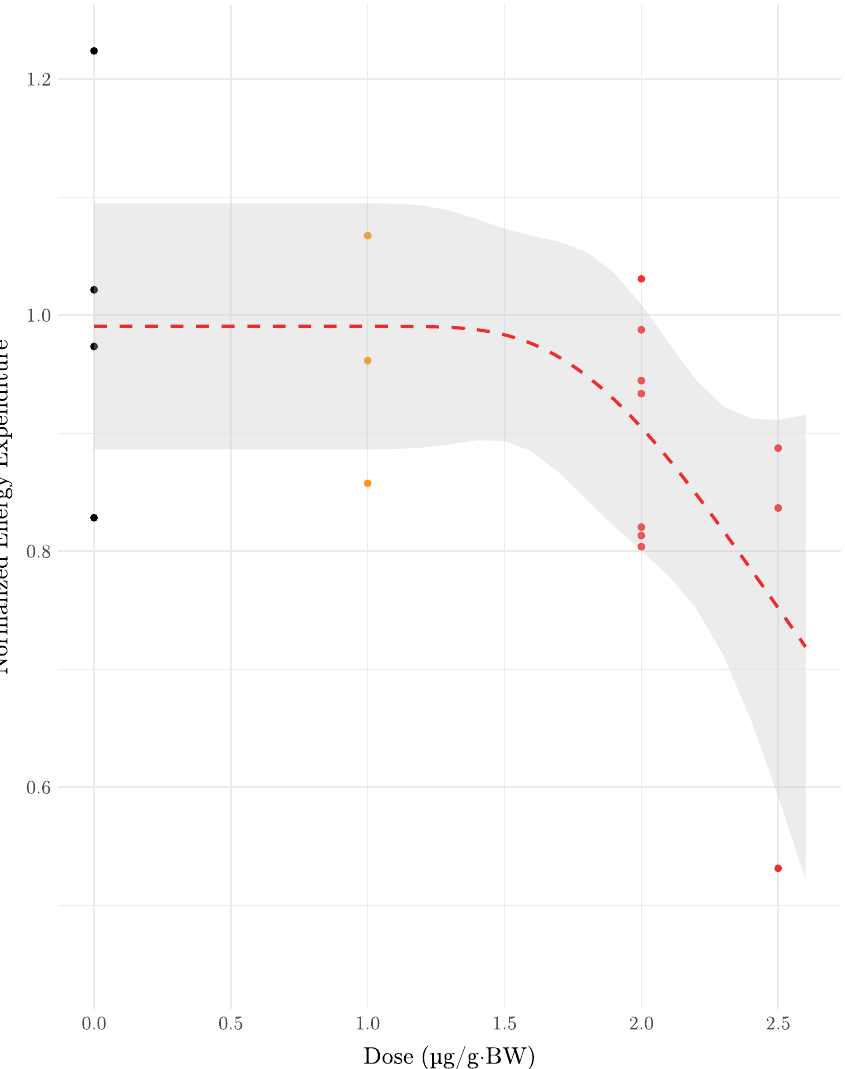
Figure 1. Energy expenditure of ruby-throated hummingbirds 1.5 h to 2 h after dosage with 0.0 µ g g − 1 to 2.5 µ g g − 1 · Body Weight (BW) imidacloprid follows a Weibull type 2 dose-response curve. Birds in the control group increased energy expenditure by an average of 1 % ± 7 % on days following dosage with the control solution, while birds in 1.0 µ g g − 1 · BW, 2.0 µ g g − 1 · BW, and 2.5 µ g g − 1 · BW groups reduced energy expenditure on dosing days by an average of 6% ± 5 % , 10% ± 3 % , and 25% ± 11% respectively. Shaded region indicates the 95 % confidence band, estimated from fitted